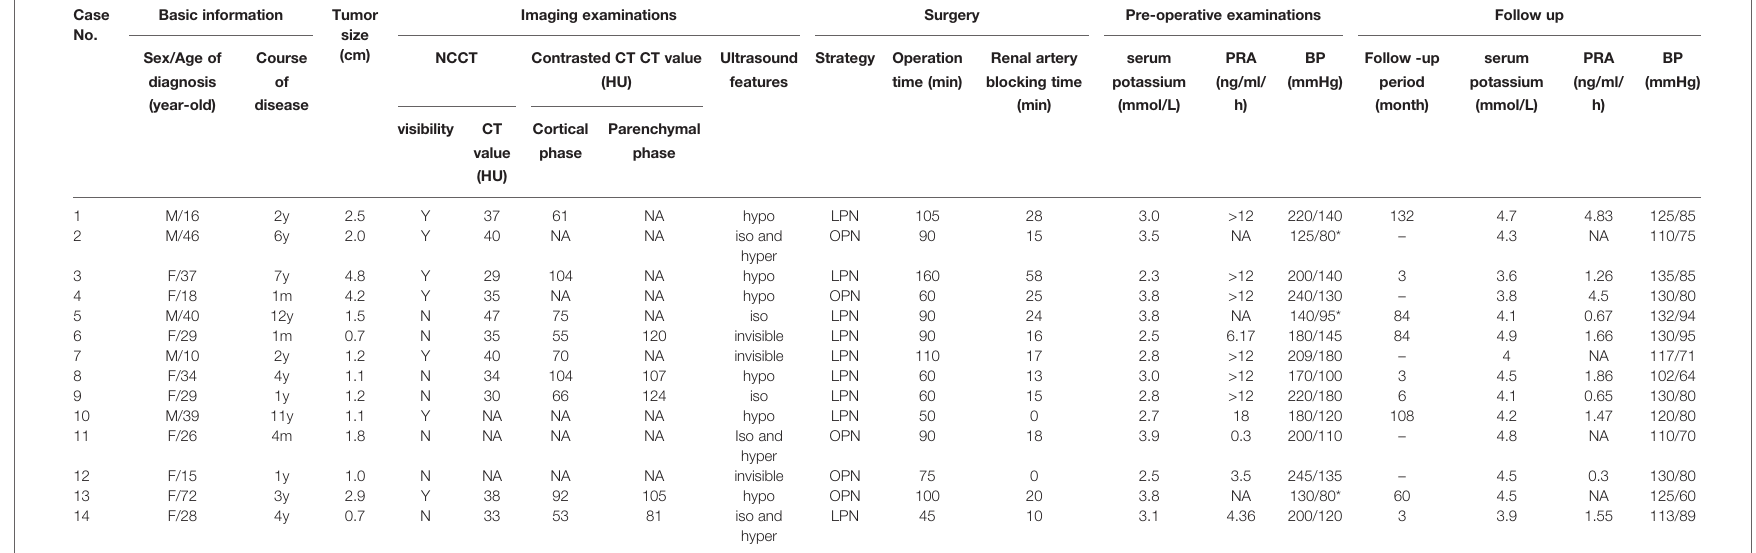
TABLE 1 | Detailed information for all JGCT patients. Case